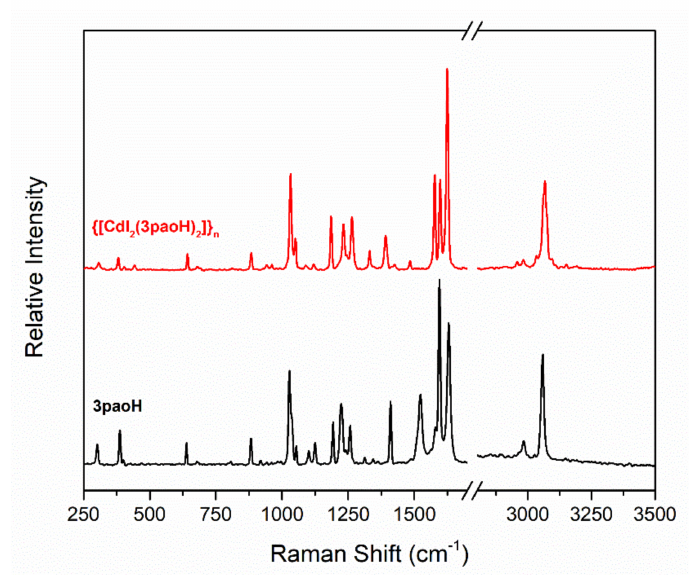
Figure 4. The FT-Raman spectrum of the ligand 3paoH (black line) and the {[CdI 2 (3paoH) 2 ]} n ( 2 ) complex (red line).